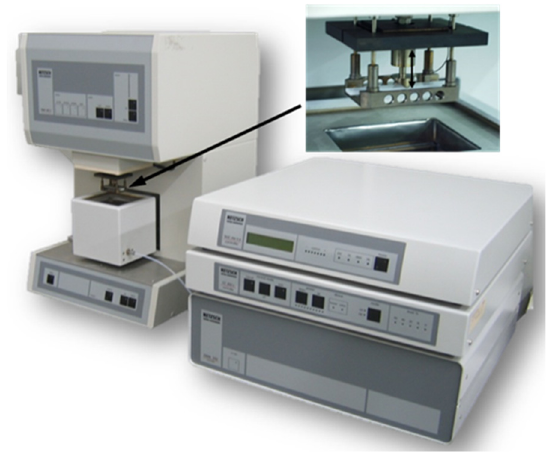
Figure 2. Research stand Netsch DMA 242 C.